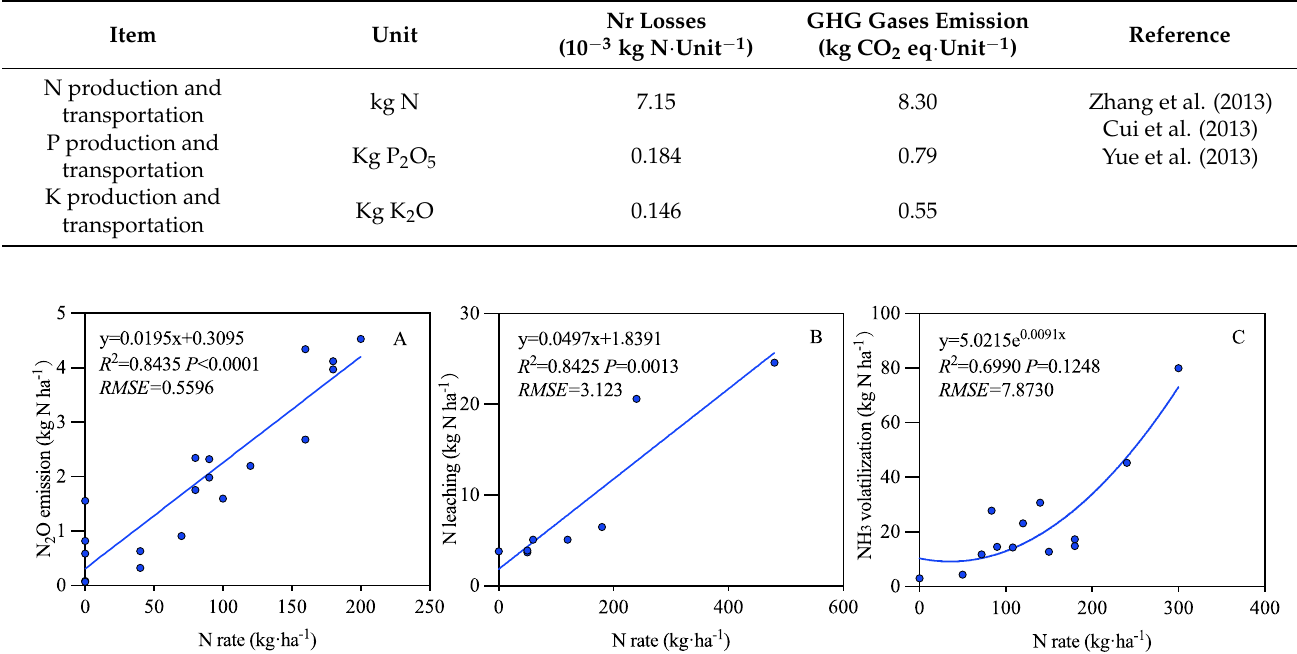
Figure A1. Relationships between N application rate and total N 2 O emission ( A ), N leaching ( B ), NH 3 volatilization ( C ) with common urea for forage sorghum production.